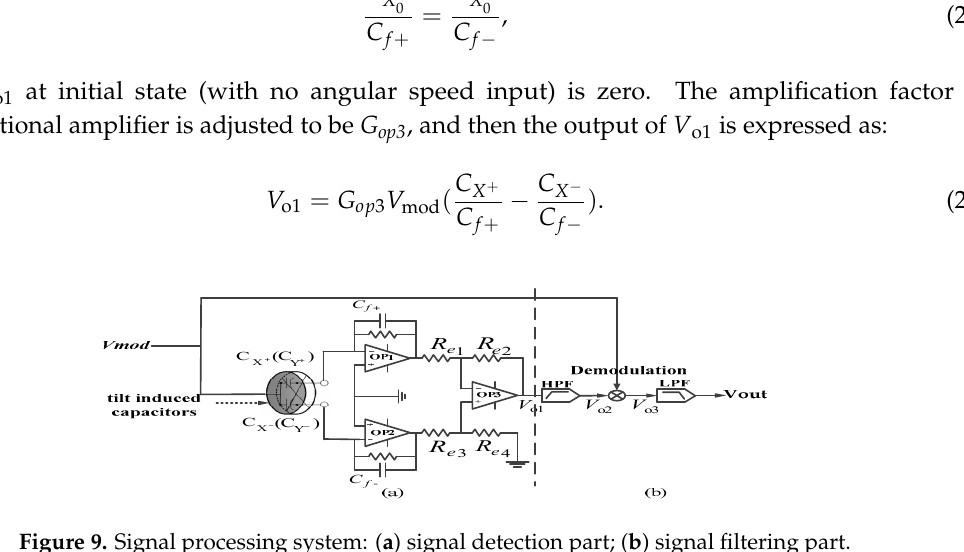
Figure 8. Capacitance difference for different deflection angles.